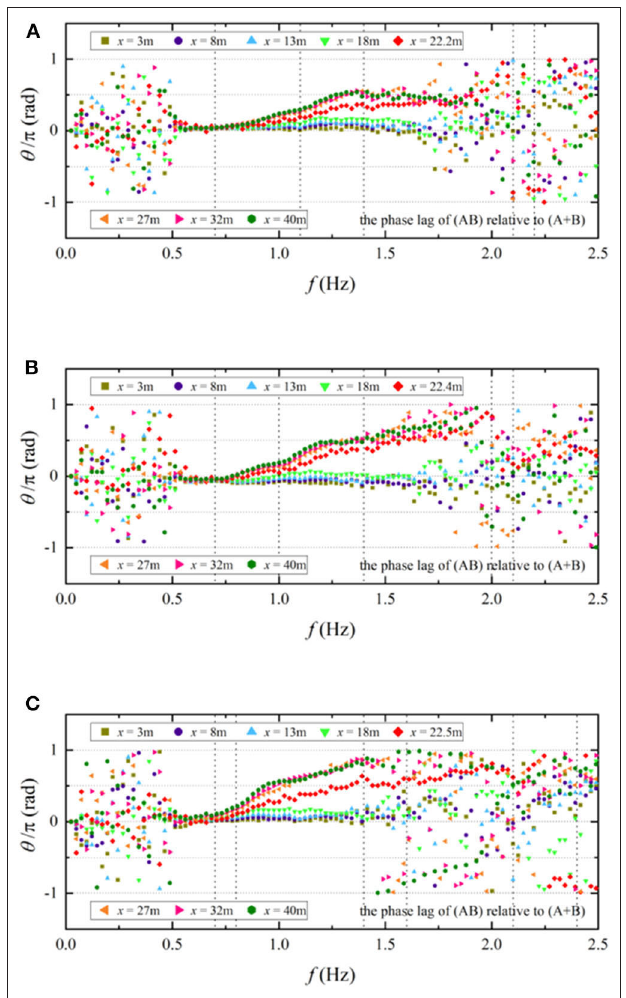
FIGURE 10 | The phase lag of the double wave groups focusing [AB, i.e., y(t) ] relative to the linear superposition of the corresponding single wave group [A + B, i.e., x(t) ]. (A) Case 1_AB, (B) Case 2_AB, (C) Case